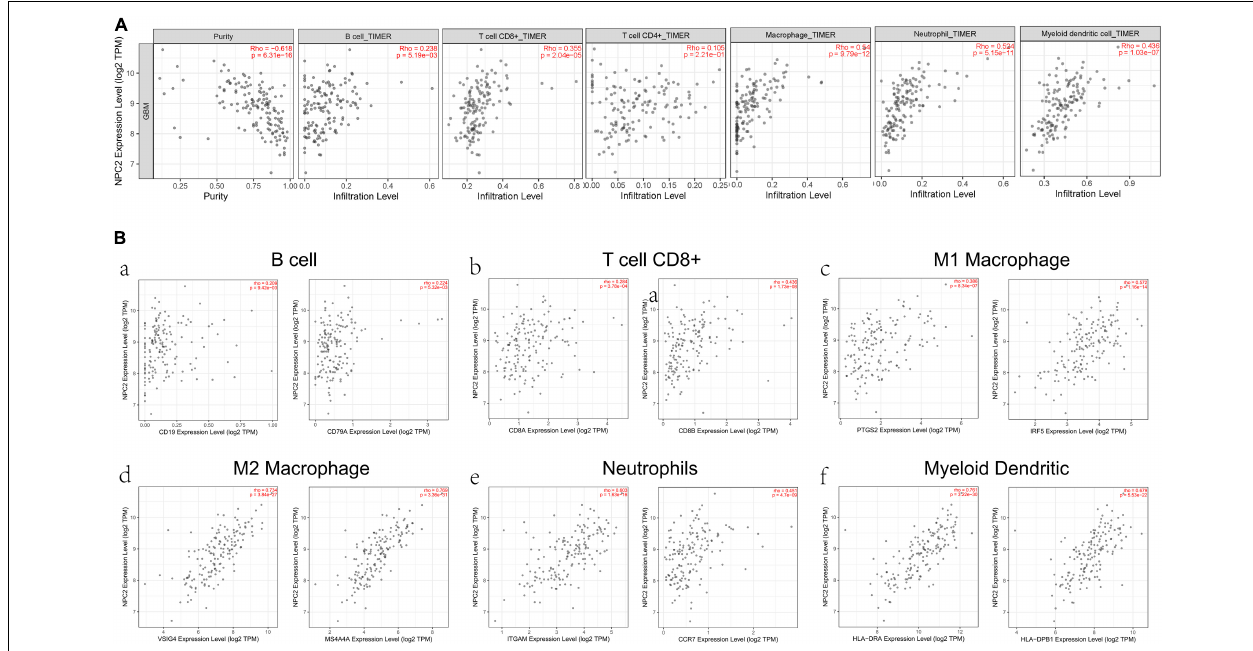
FIGURE 5 | Correlation between immune cell and NPC2 expression. (A) The relationship between different functional immune cells, such as B cell, T cell CD8+, T cell CD4+, Macrophage, Neutrophil, and Myeloid dendritic cell with NPC2 expression in GBM. (B) The correlation NPC2 expression with canonical markers for six cell types: B cell, T cell CD8+, M1 Macrophage, M2 Macrophage Neutrophil, and Myeloid dendritic cell.